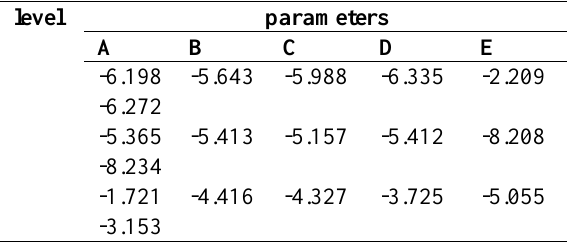
mean of Ra for SN ratio level